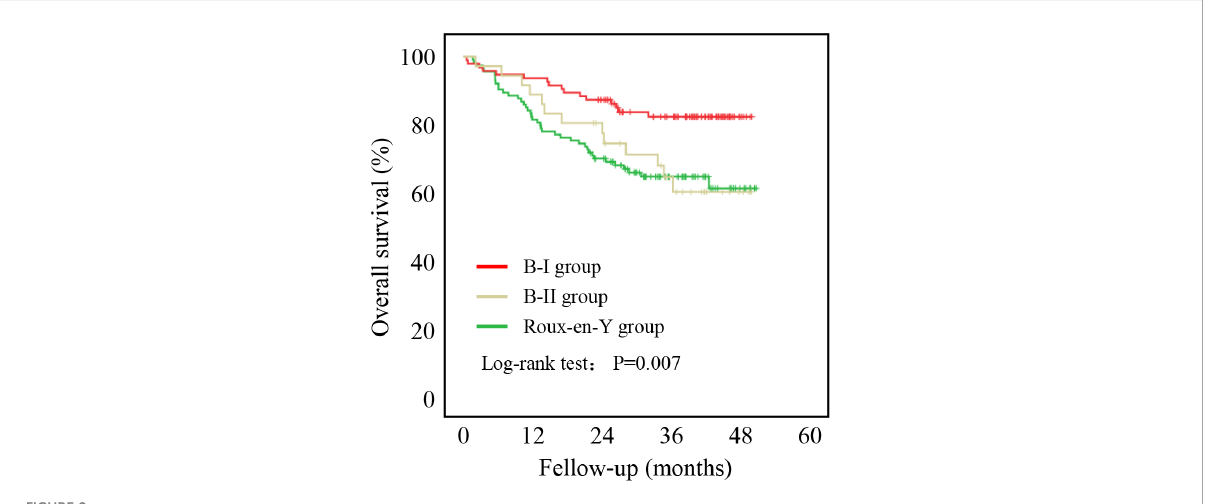
FIGURE 2 Five-year overall survival curve calculated using the Kaplan-Meier method comparing B-I, B-II, and R-Y